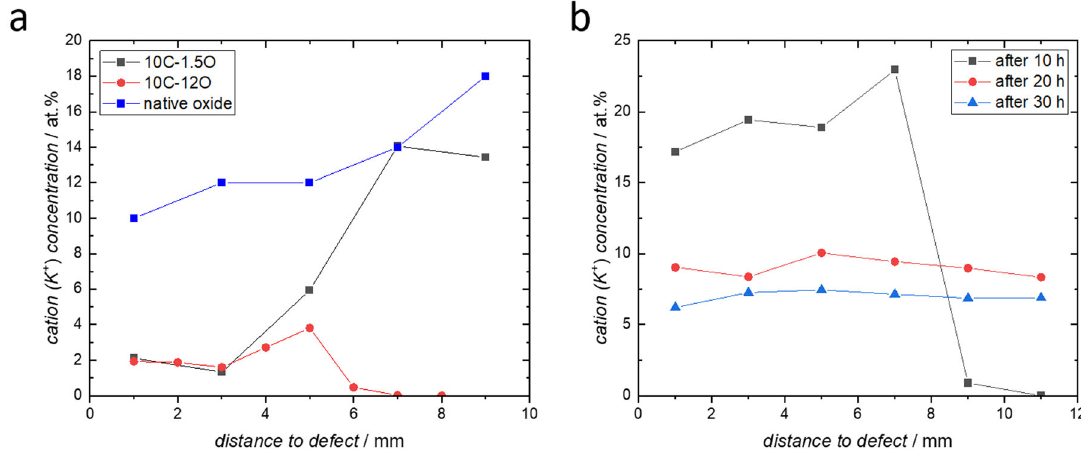
Fig. 12 Cation concentrations on the surface from XPS. Concentration of potassium on the surface obtained using XPS from various locations on a the samples 10C-1.5O, 10C-12O (after allowing cathodic spreading to continue ex situ following the SKP measurements in Fig. 5c) and chromium with native oxide after cation migration measurements, and b the sample 10C-1.5O measured at different times after commencement of electrolyte spreading.